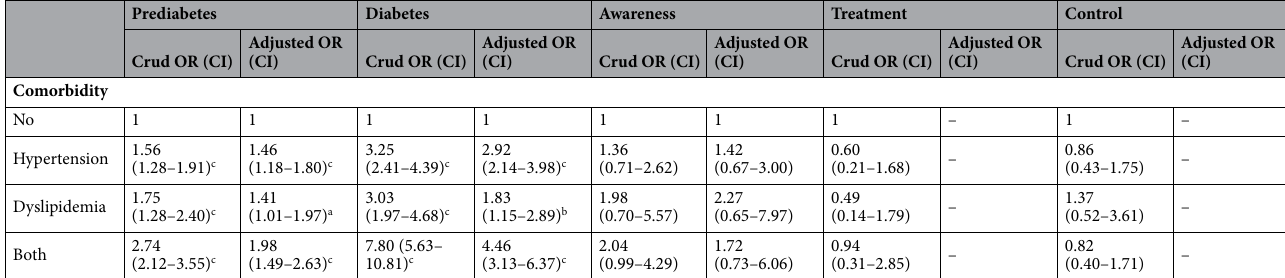
Table 2. Correlates of prediabetes, diabetes, awareness, treatment and FBS control according to the logistic regression in DehPCS. a p-value < 0.05, b p-value < 0.01, c p-value < 0.001.